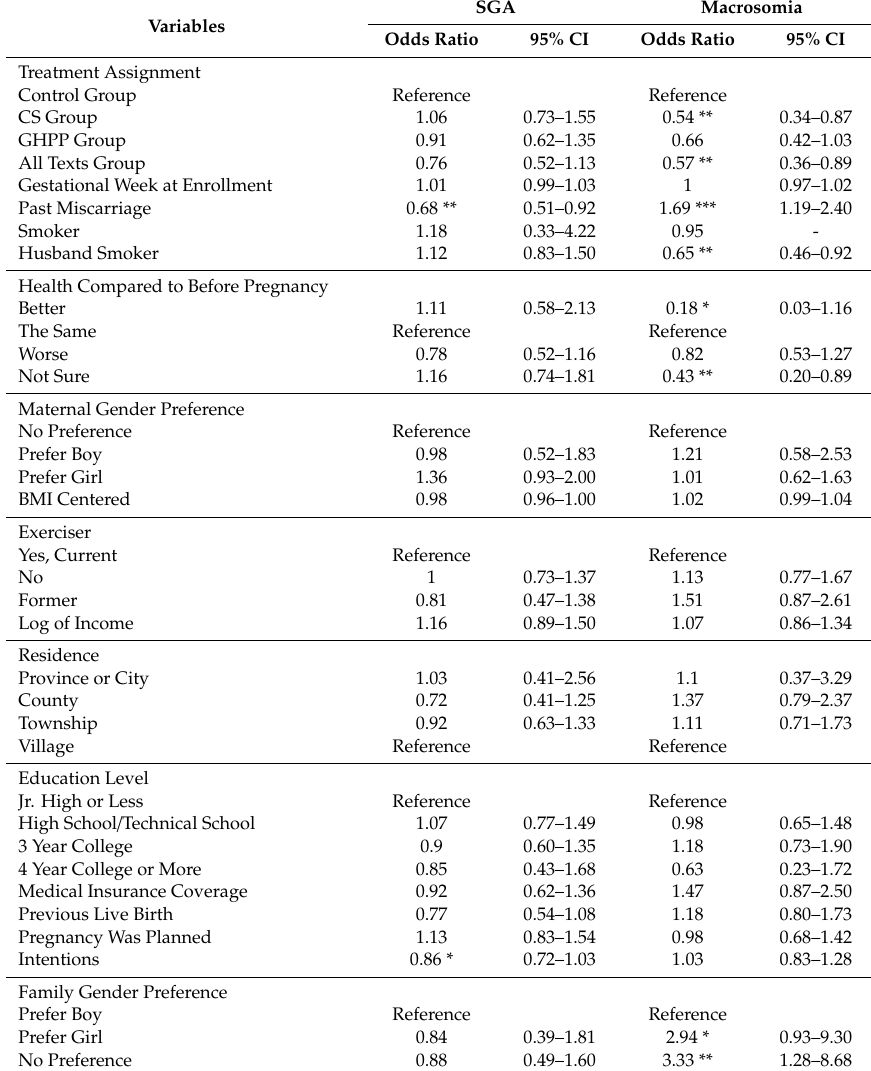
Table 4. Logistic Regression models with SGA and Macrosomia as dependent variables, Adjusted for Imbalance and Potential IWGA